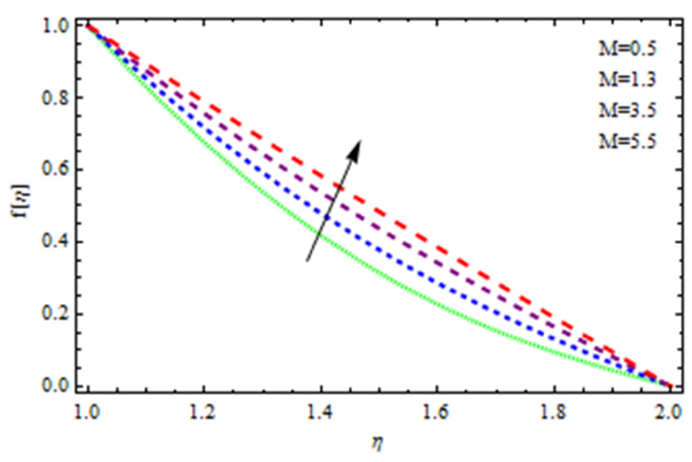
Figure 5. Influence of M on the velocity curve.